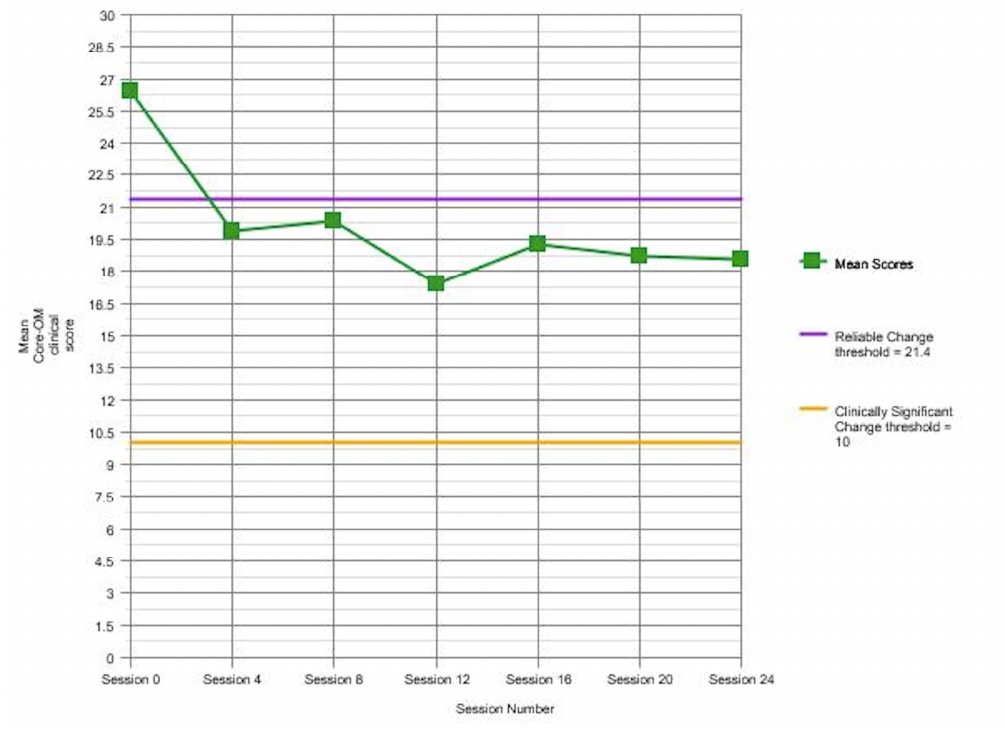
Figure 4: Mean Clinical Core-OM score: 7 short-term clients